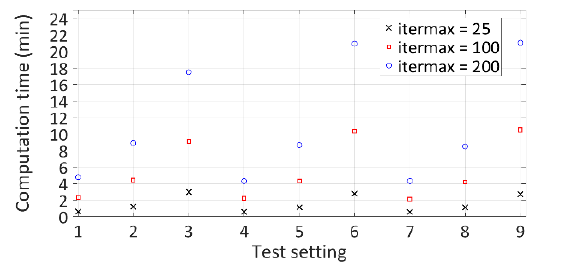
Figure 8: Computation time with the applied